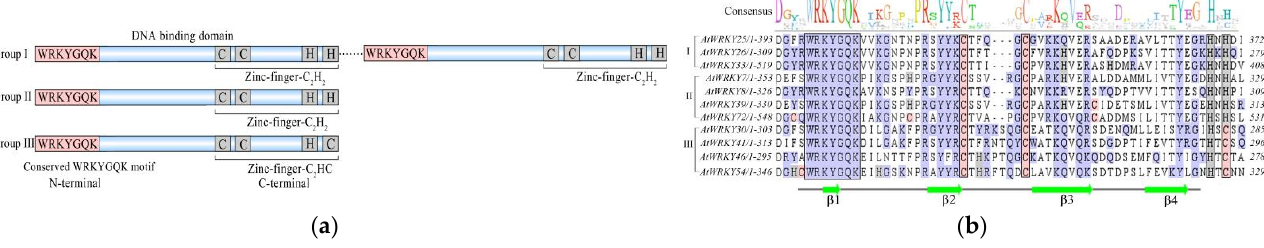
Figure 2. Structural features of WRKY TFs. ( a ) Structural features and classification of WRKY TFs. The pink areas indicate the N-terminal WRKYGQK sequence structure, the blue areas represent amino acid residues and the gray area indicates the head and end of the C-terminal zinc-finger structure. ( b ) Structure of WRKY TFs involved in the response to high-temperature stress in Arabidopsis . The black box indicates the conserved region and zinc-finger structure, and the green arrow indicates 4 β -sheets.